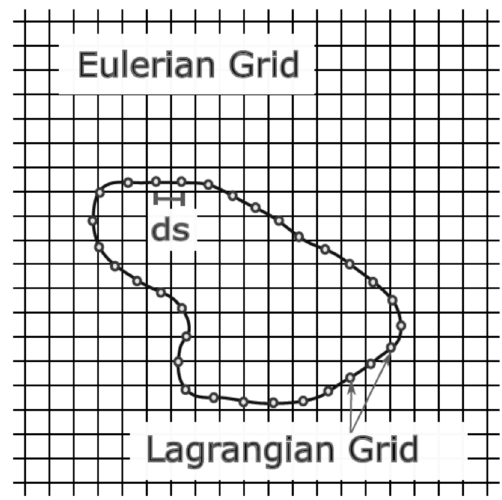
Figure 11. The static Eulerian grid, spread over the fluid domain, and the moving Lagrangian grid with the ds resolution, defined on the boundary of the fluid (based on de Lima et al., 2007: Figure